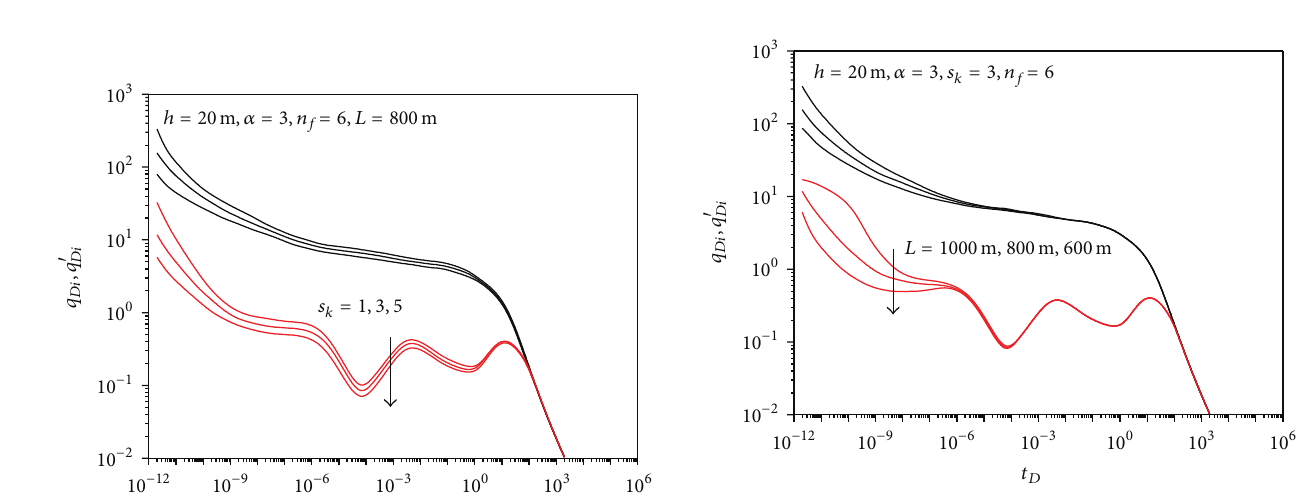
Figure 8: Effect of different fracture stages on type curves.